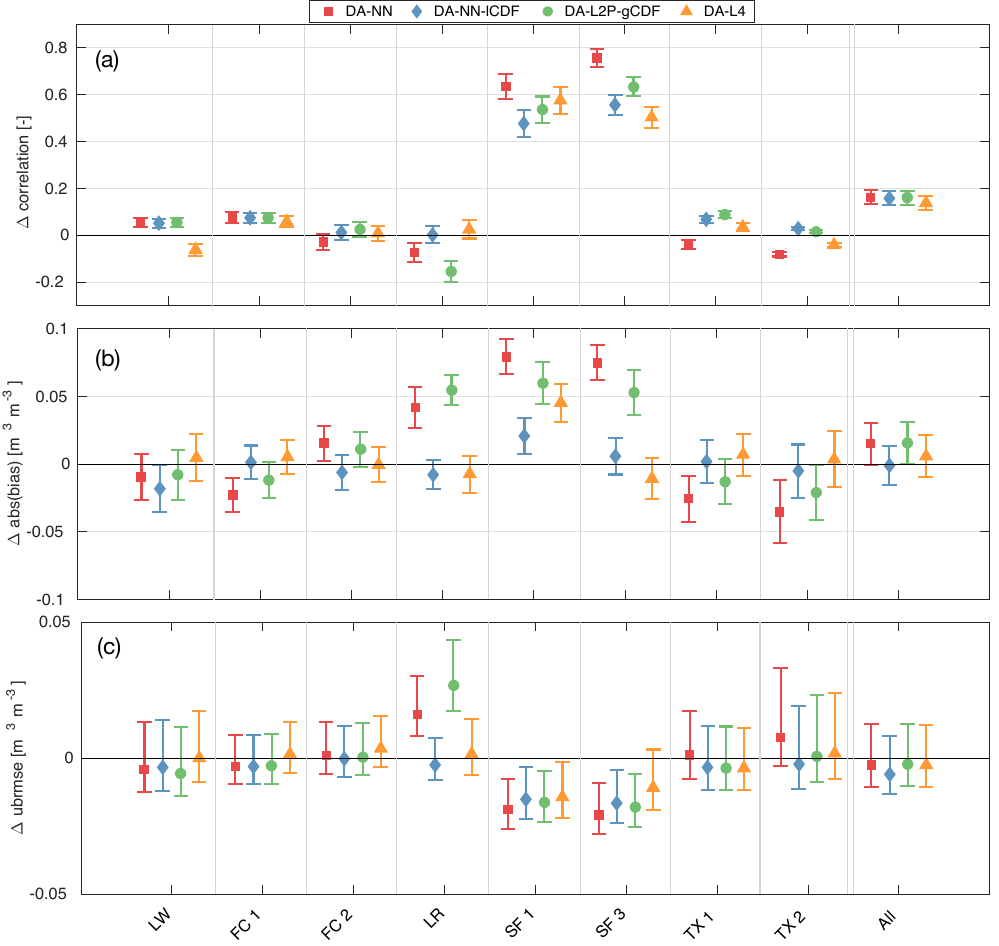
Figure 3. Same as Figure 2, but for the root